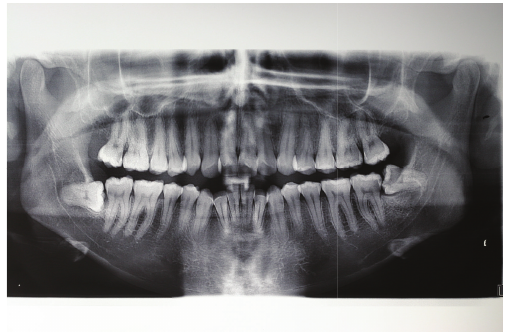
Figure 2: Preoperative orthopantomography.